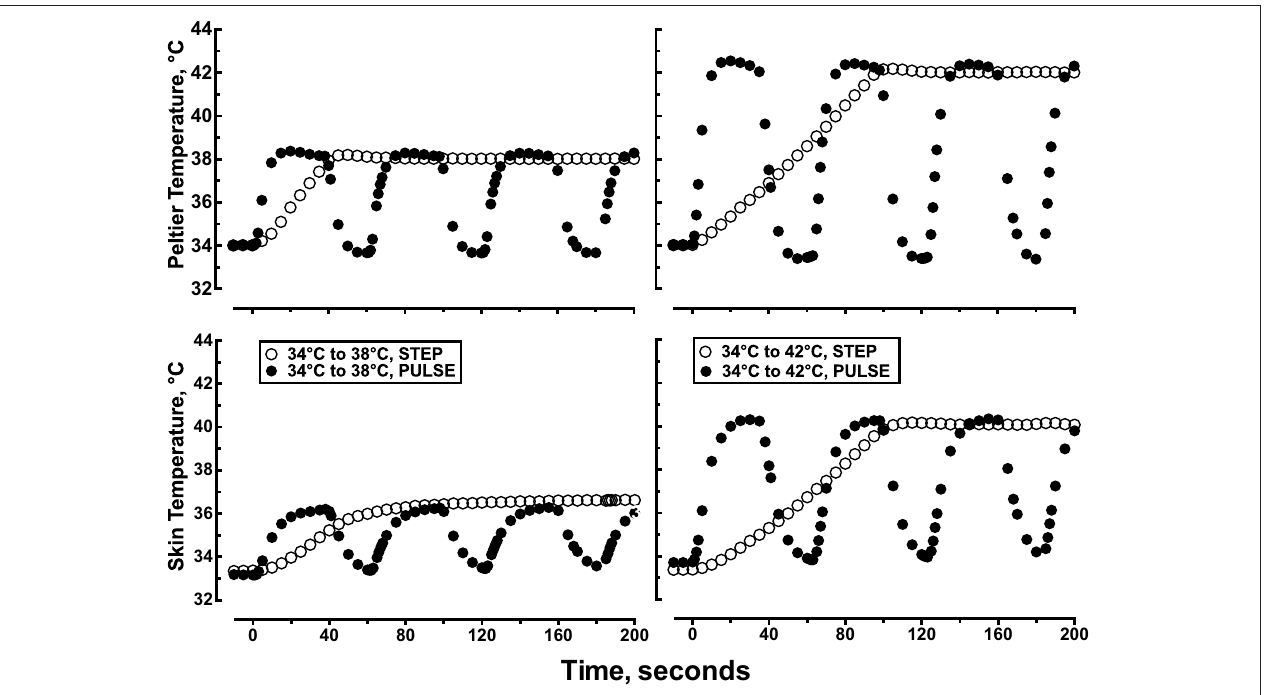
FIGURE 2 | Representative data showing the first 200s of the time course of changes in Peltier and skin temperature during: (1) a single step change in local skin temperature from 34 to 38 ◦ C, (2) a single step change in local skin temperature from 34 to 42 ◦ C, (3) pulsed heating, 1 pulse per min, each pulse represented a step change in local skin temperature from 34 to 38 ◦ C, rate of change = 1.0 ◦ C •s − 1 , 50% duty cycle, or (4) pulsed heating, 1 pulse per min, each pulse represented a step change in local skin temperature from 34 to 42 ◦ C, rate of change = 1.0 ◦ C •s − 1 , 50% duty